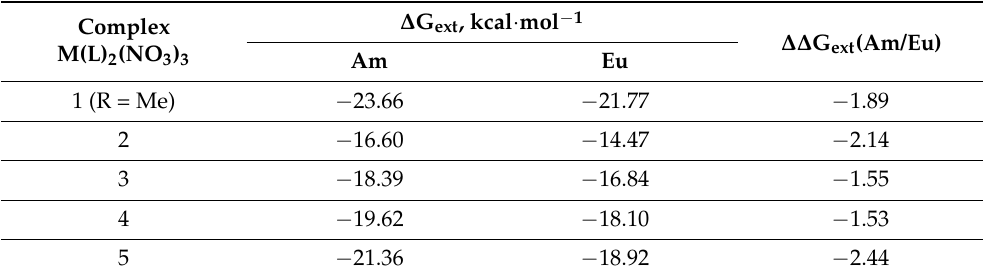
Table 1. Calculated extraction energies ( ∆ G ext ) and predicted selectivities of ligands in the separa- tion of Am(III) and Eu(III) ( ∆∆ Gext(Am-Eu)) by solvent extraction into kerosene. Reprinted with permission from ref. [157]. Copyright 2015 Royal Society of Chemistry.